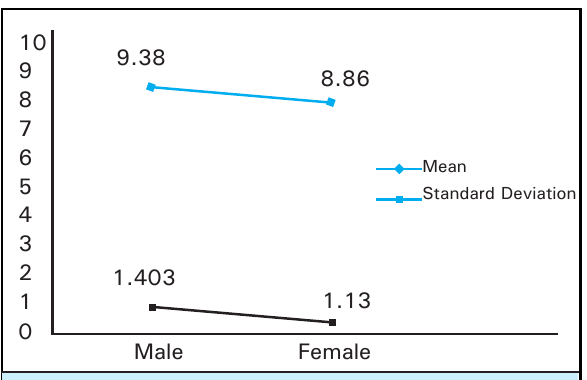
Figure 2. Hyperuricemia gender cross tabulation.